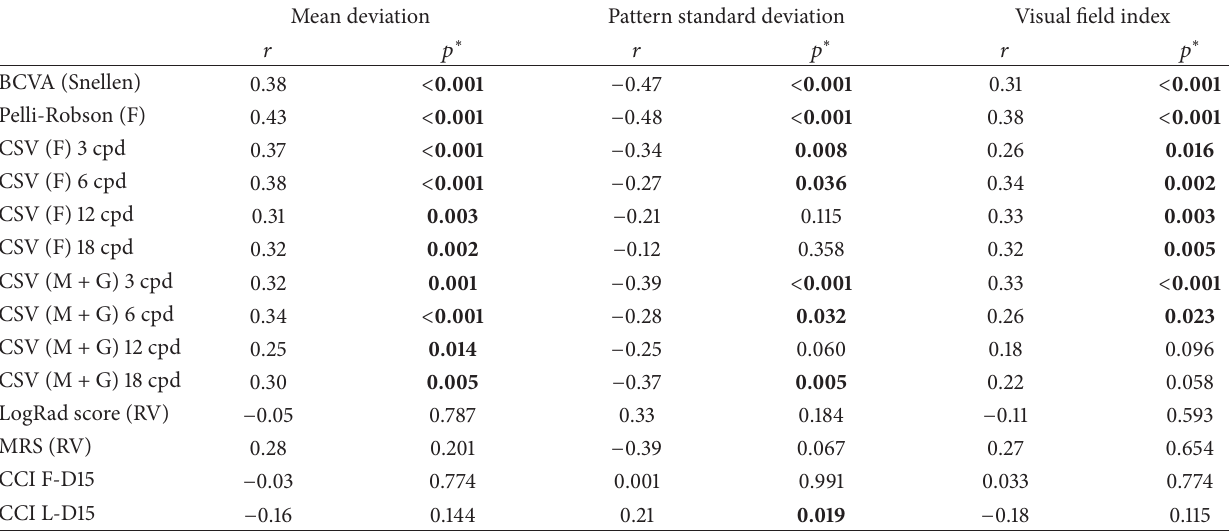
Table 4: Spearman correlation coefficients ( 𝑟 ) between visual field parameters and contrast sensitivity, reading ability, and color vision